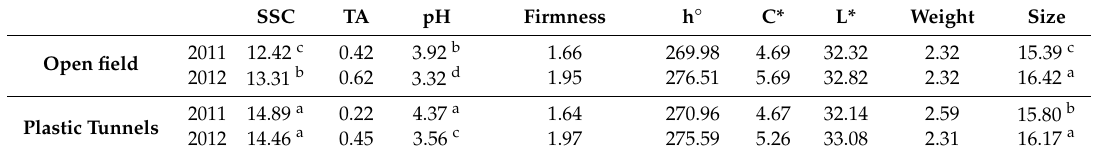
Table 2. E ff ect of cultivation system and sampling year on the parameters evaluated for blueberry fruits. SSC TA pH Firmness h ◦ C* L* Weight Size